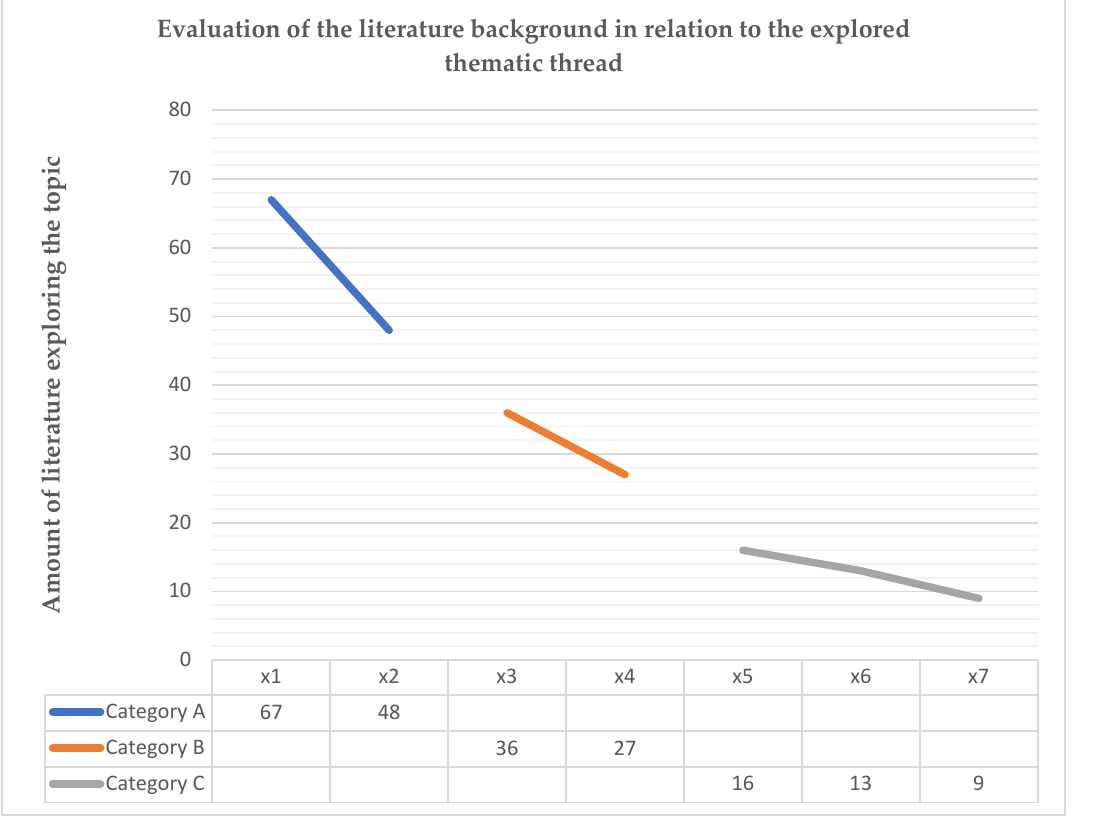
Figure 1. Evaluation of the literature background in relation to the explored thematic thread.